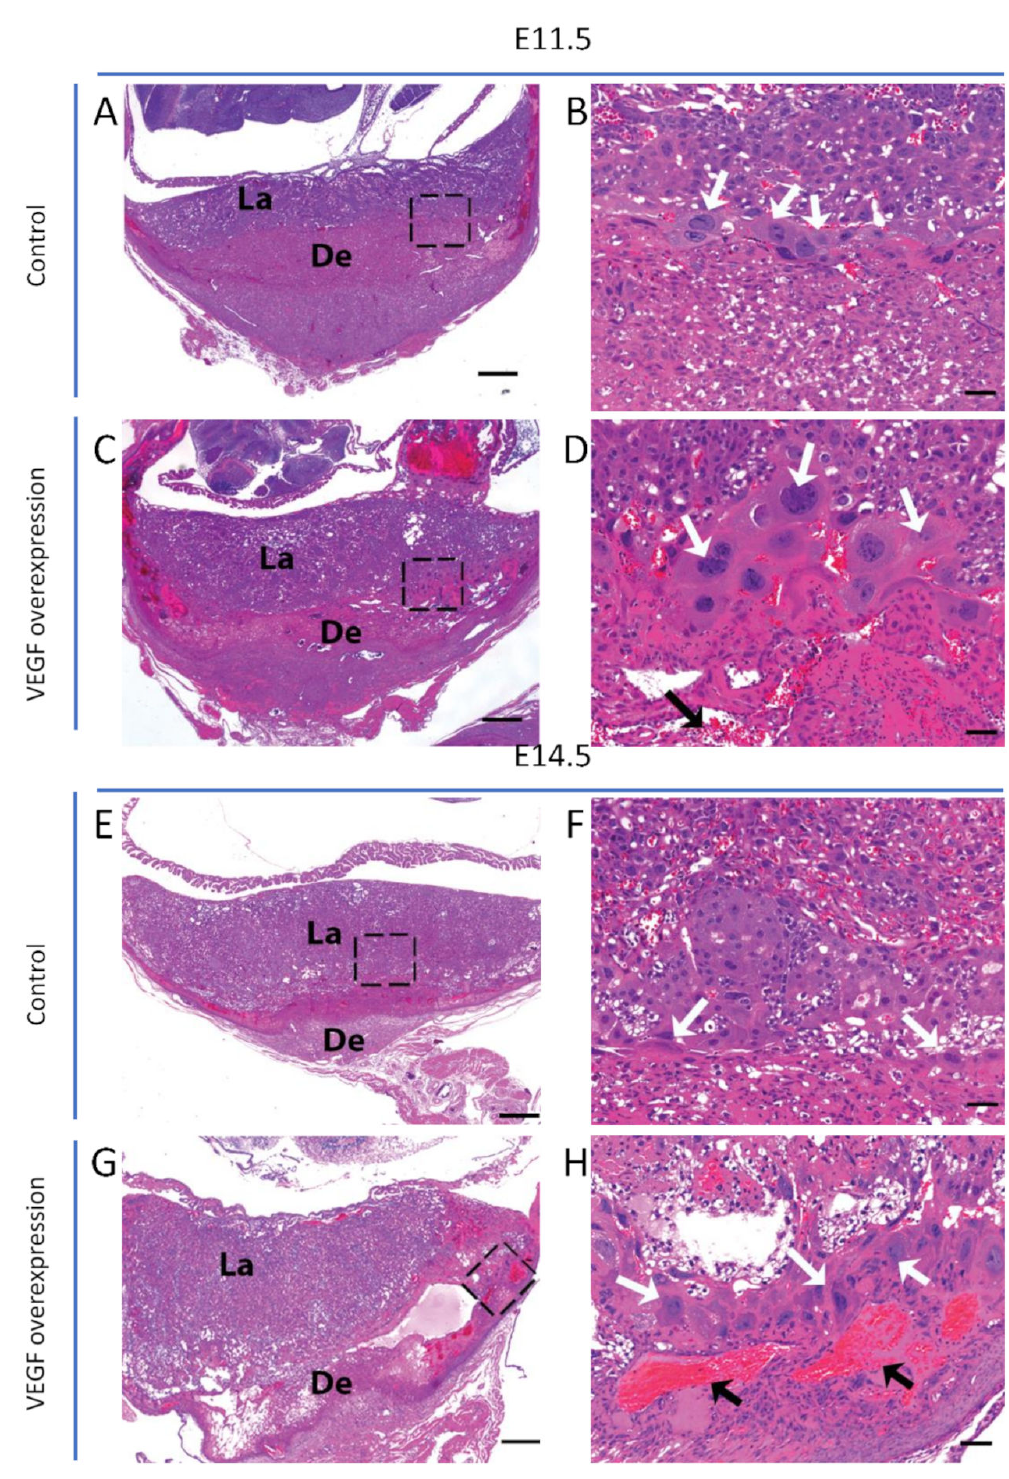
Figure 1. Alteration of placental vascular spaces and associated TGC differentiation in endometrial VEGF-overexpressing dams. Placental sections stained with H&E at E11.5 ( A – D ) and E14.5 ( E – H ). Histological sections of placentas from endometrial VEGF-overexpressing dams ( C , G ) showing severely dilated maternal blood spaces (indicated by black arrows within the insets, D , H ) and increased number and size of TGCs (indicated by white arrows within the insets, D , H ) as compared to the control ( A , B , E , F ). De, decidua; La, labyrinth; TGC, trophoblast giant cells. Scale bar in A, C , E , G = 500 µ m. Scale bar in B , D , F , H = 50 µ